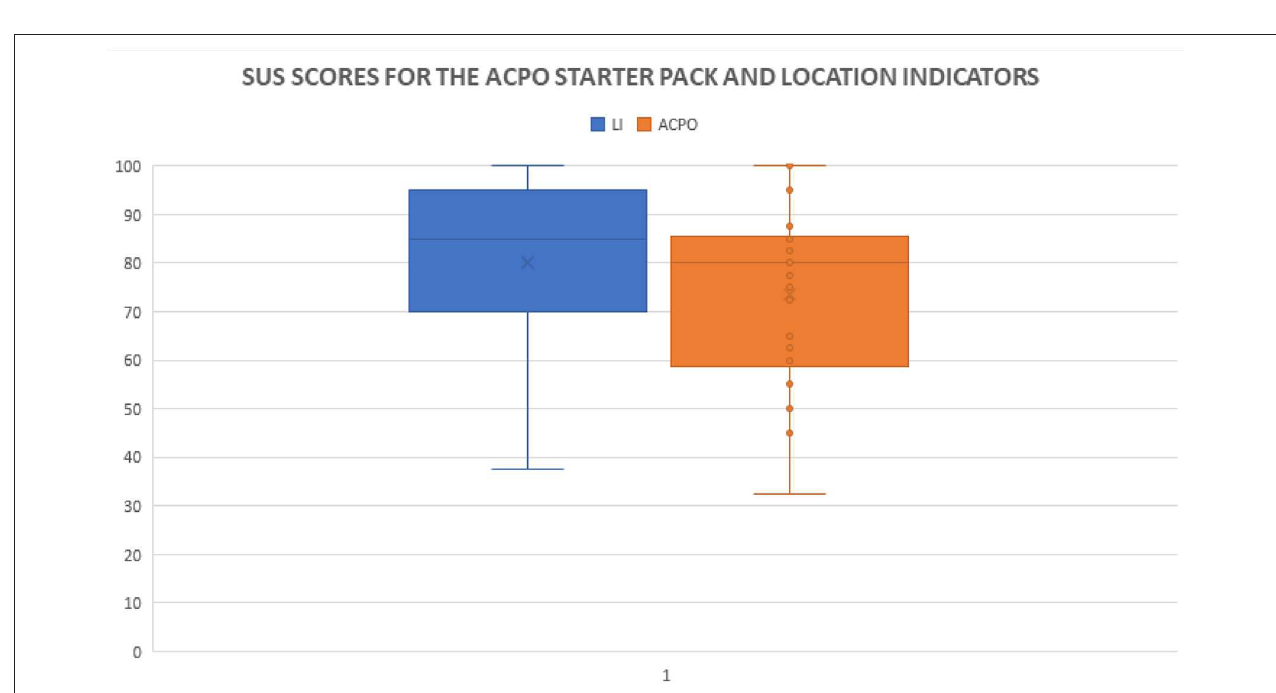
FIGURE 11 | Average usability scores for each